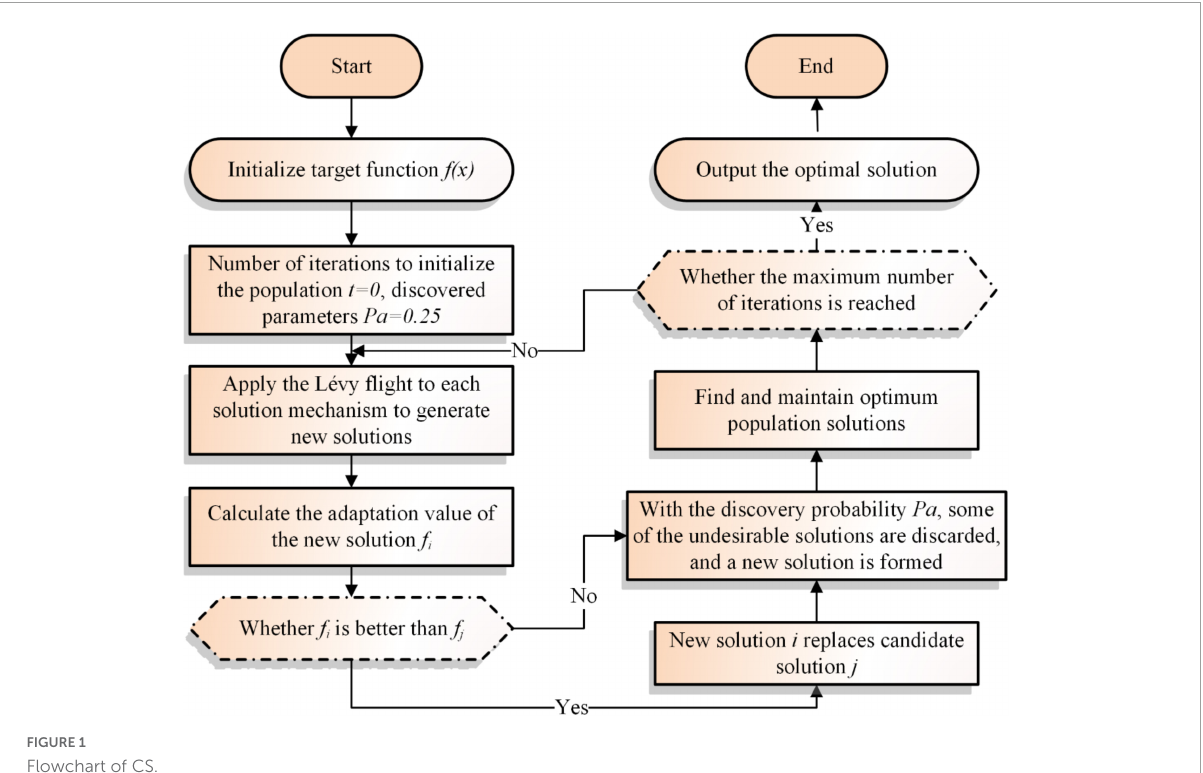
FIGURE1 Flowchart of